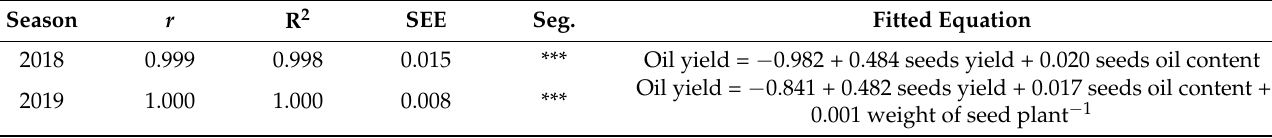
Table 10. Correlation coefficient (r), coefficient of determination (R 2 ), and standard error of the estimates (SEE) for predicting oil yield (t ha − 1 ) in two growing